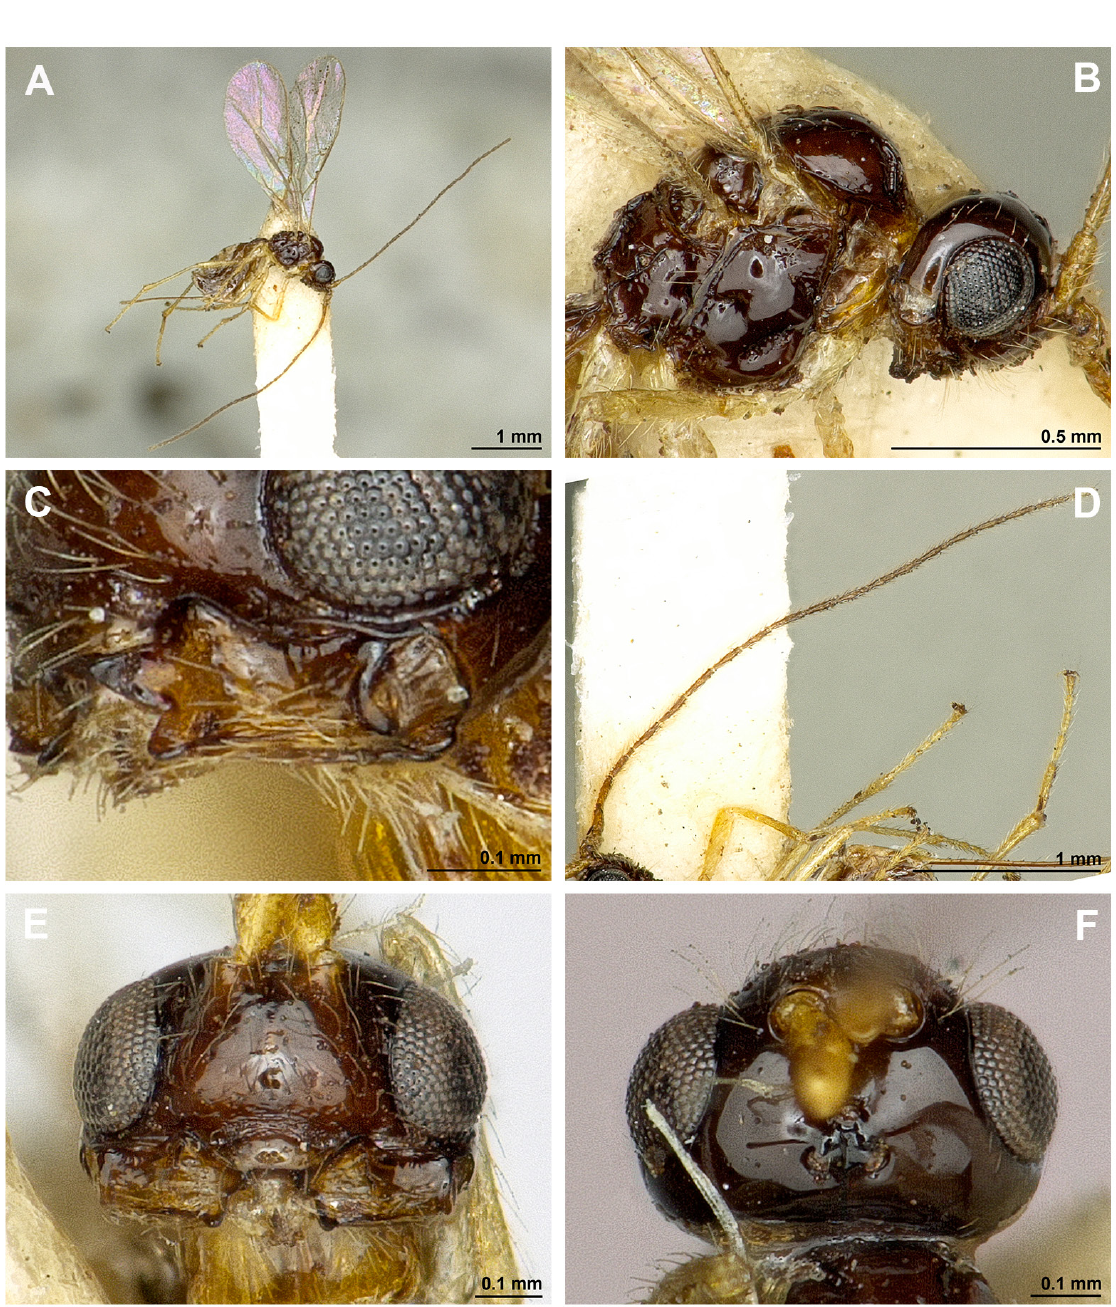
Fig. 80. Asobara zululana Peris-Felipo, sp. nov., ♀, holotype (BMNH 1926-277). A . Habitus, lateral view. B . Head and mesosoma, lateral view. C . Mandible. D . Antenna. E . Head, front view. F . Head, dorsal